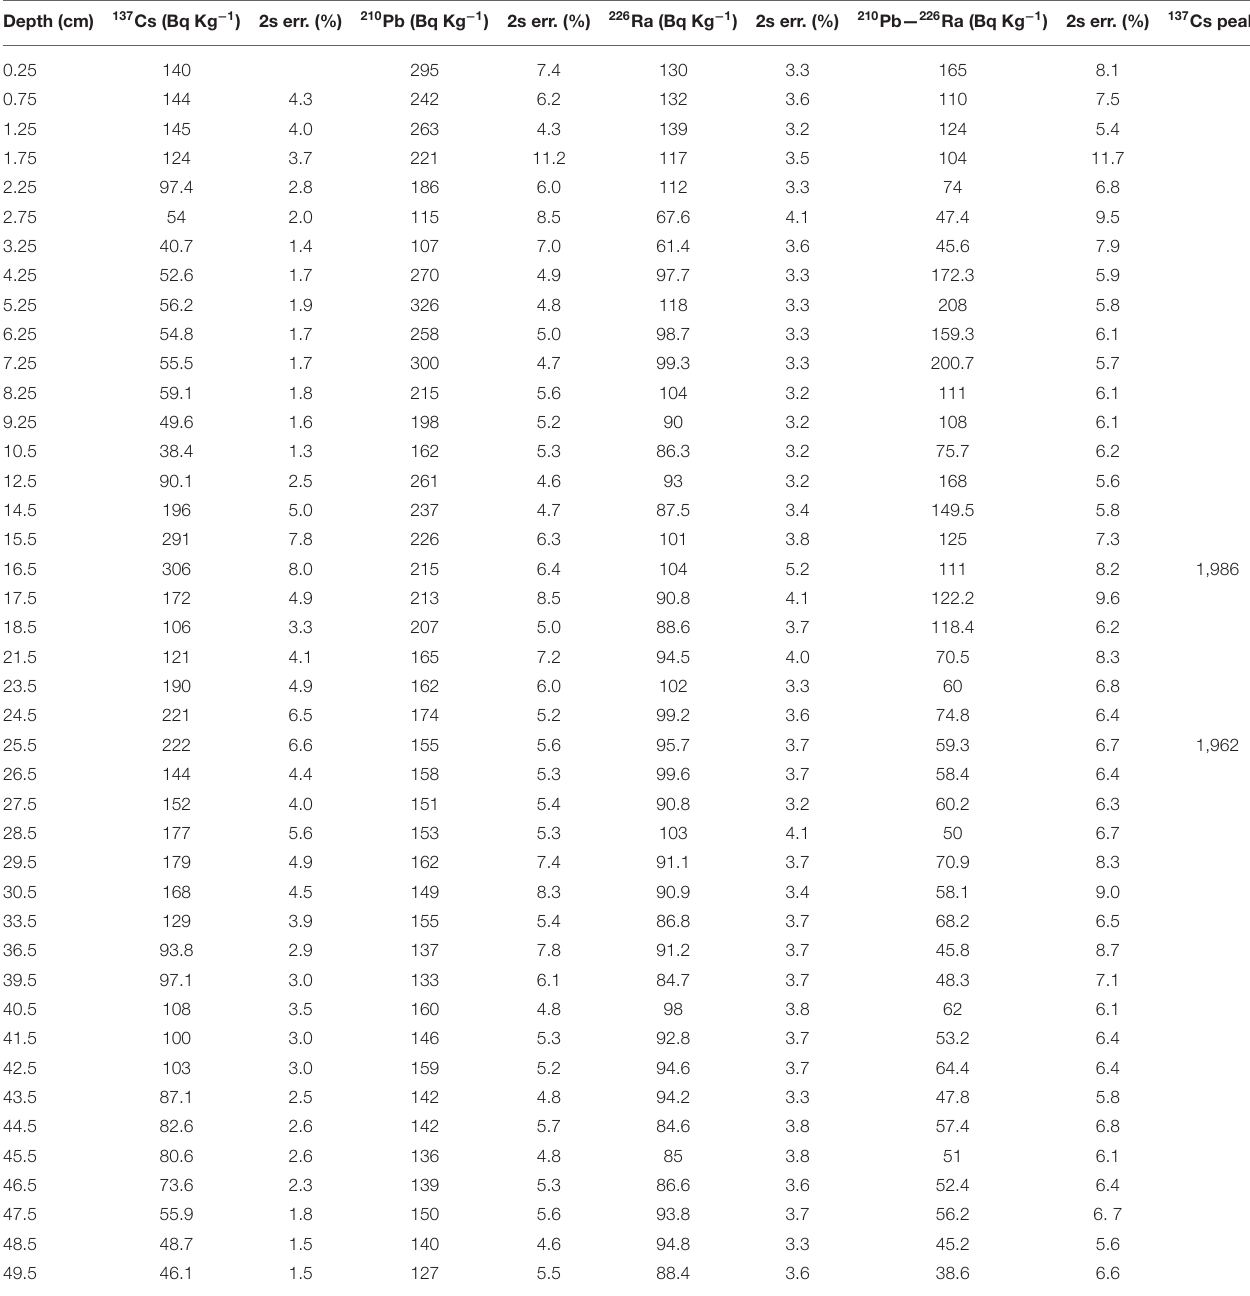
TABLE 2 | 210 Pb, 226 Ra, and 137 Cs measurements of